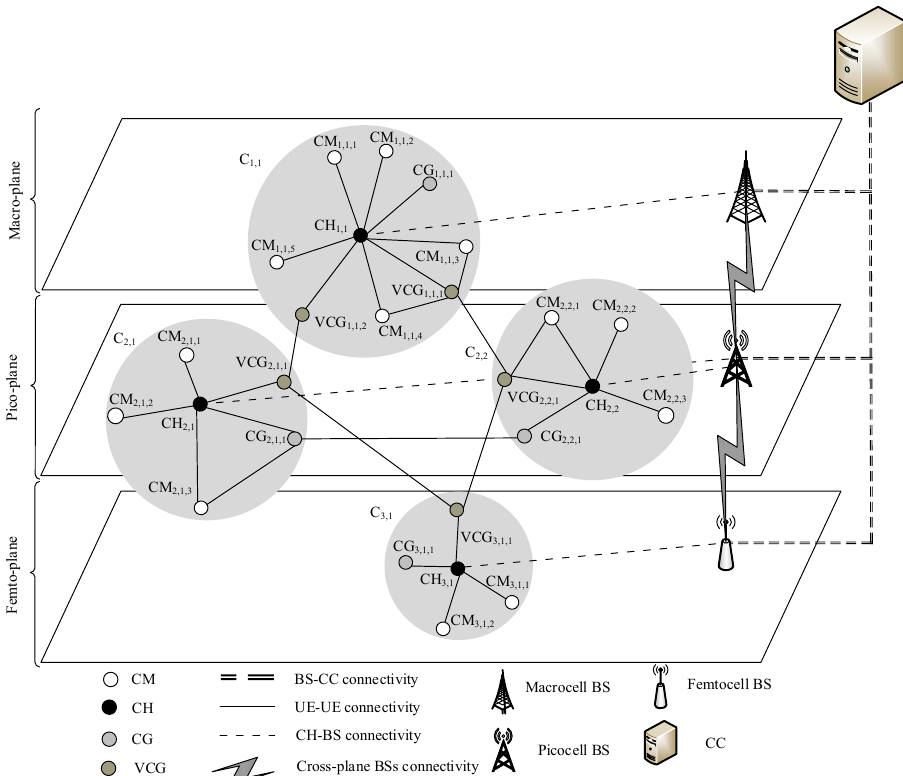
Figure 1. Our framework consists of DQN-based vertical routing over a clustered FANET in a 5G network. Cluster C 1,1 is in the macro-plane, clusters C 2,1 and C 2,2 are in the pico-plane, and cluster C 3,1 is in the femto-plane. Gray-shaded area represents a cluster boundary (i.e., the transmission range of a CH) across different network planes. CG 1,1,1 and CG 3,2,1 are not connected with CGs of other clusters. Explanation of the function of the network entities is presented in Table